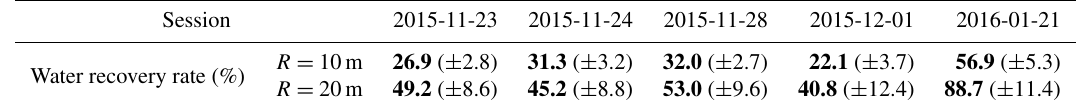
Table 5. The water recovery rate within 10m / 20m (average value in bold ± σ ) around the center of the MM snow pile.